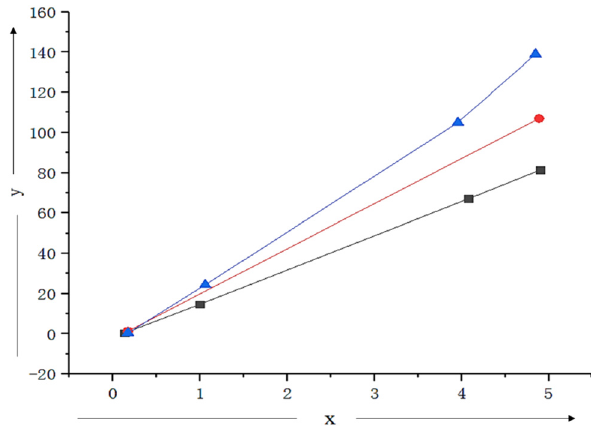
Figure 4: The distribution of high - and low - frequency superposition motion of